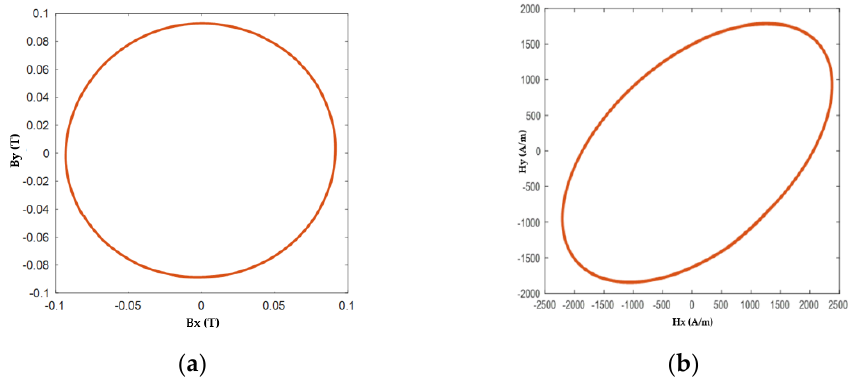
Figure 5. Loci of ( a ) Magnetic Flux Density (B) and ( b ) Magnetic Fields Strength (H) with 90 mT magnitude of B.